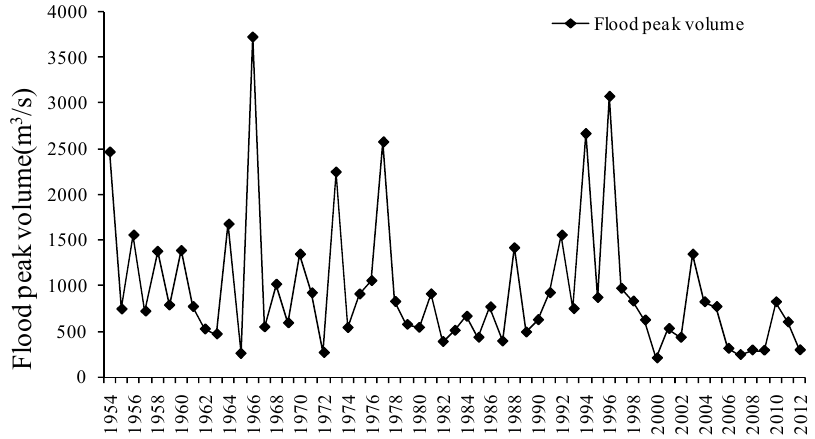
Figure 5. Annual flood peak volume of Zhangjiashan from 1951 to 2012.